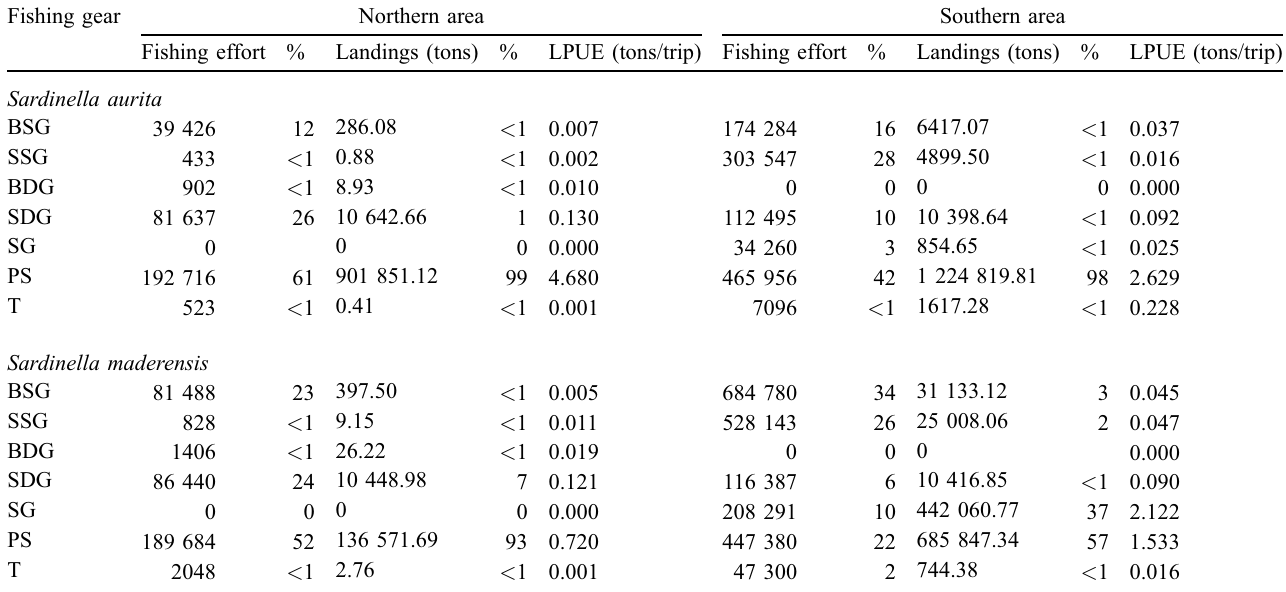
Table 1. Total landings (tons), corresponding fi shing effort (number of trips) and LPUE (landings per unit effort) per fi shing gear for Sardinella aurita and Sardinella maderensis in the northern and southern area off Senegal for the period 2004 – 2013. Bottom set gillnet (BSG), surface-set